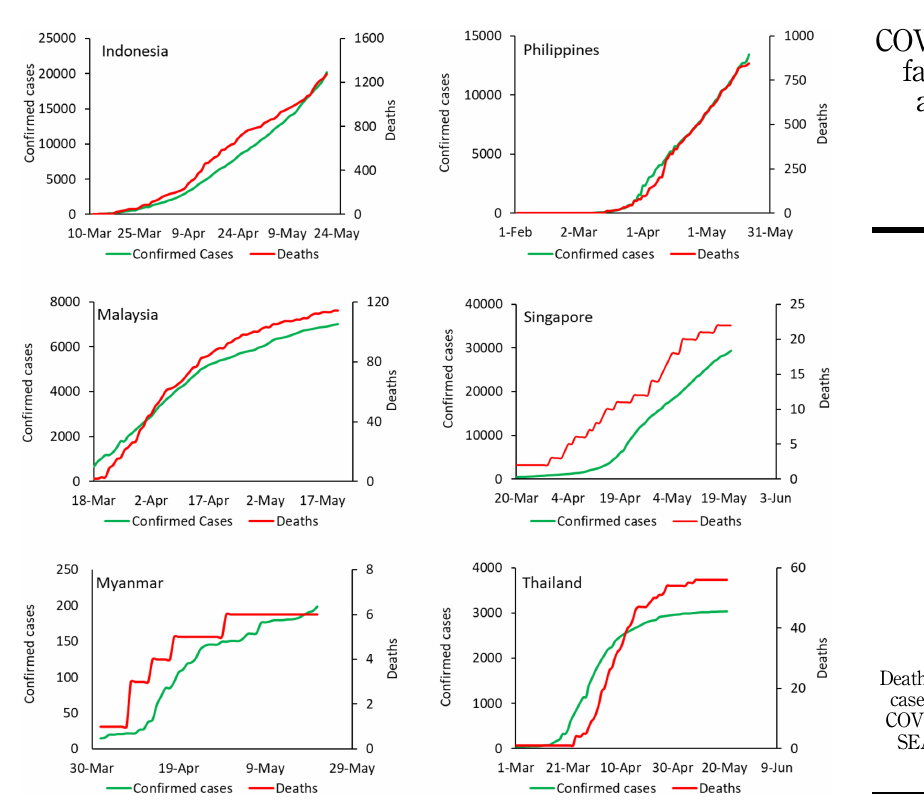
Figure 1. Deaths and